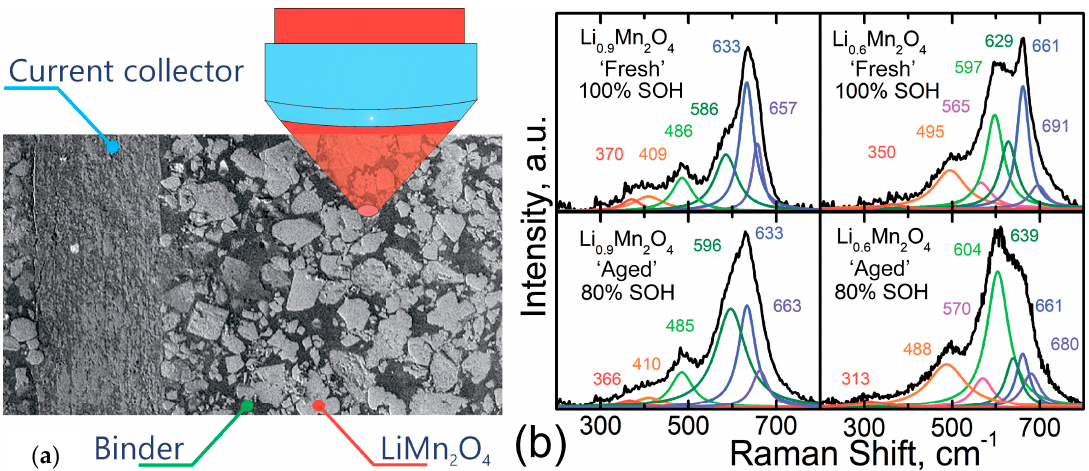
Figure 1. ( a ) Experimental scheme of the CRM measurements in LiMn 2 O 4 (LMO) cathodes; ( b ) Raman spectra of LMO cathodes with different SOC and SOH integrated over the surface of an active particle.